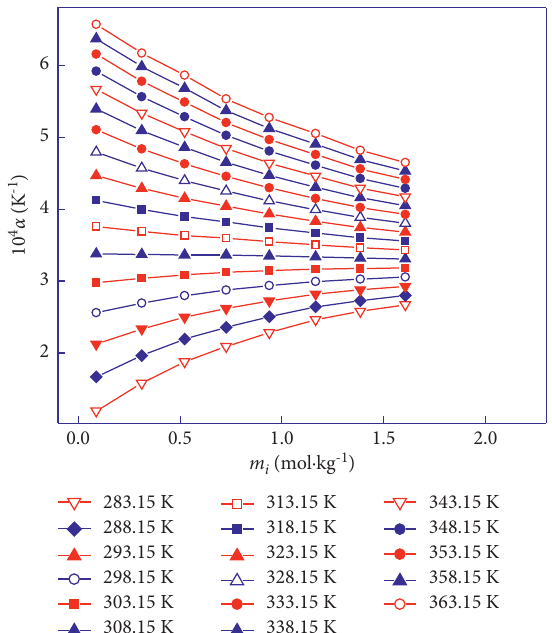
Figure 2: The coefficient of thermal expansion of YCl 3 aqueous solutions against temperature and molality at